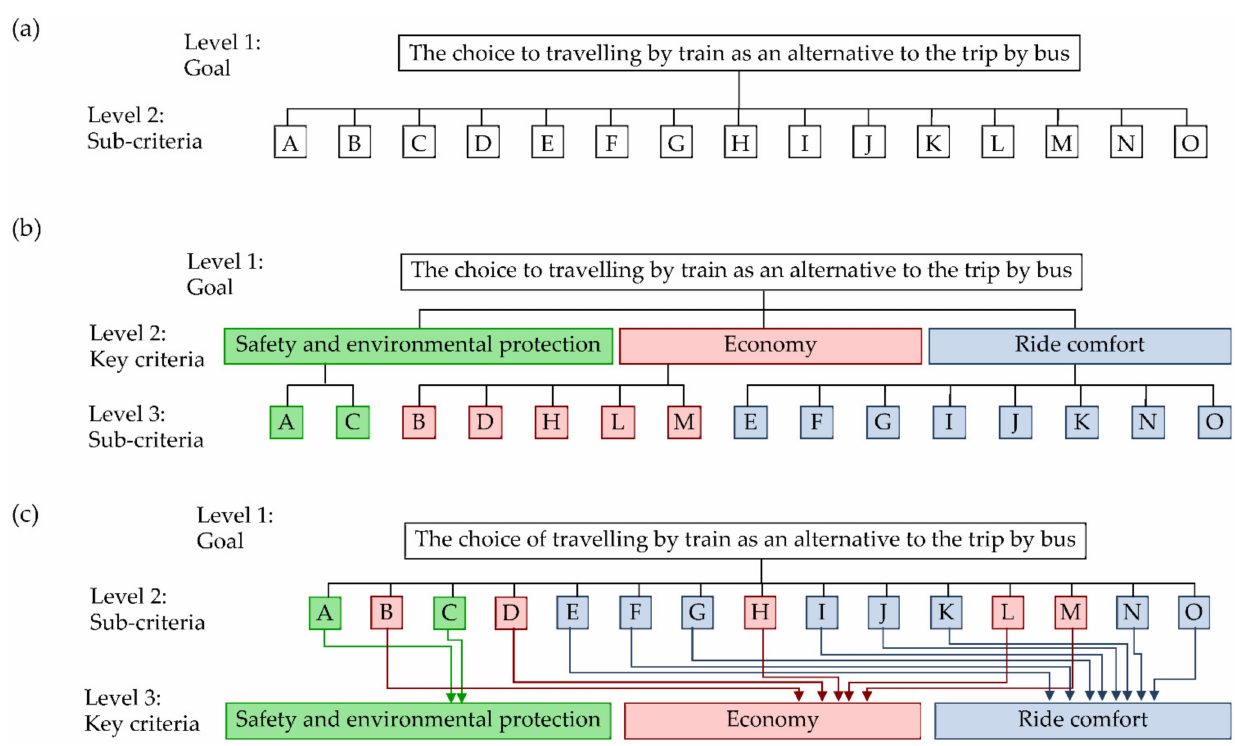
Figure 2. Calculating the weights of criteria determining the choice of passengers to travel by train as an alternative mode of transport to travel by bus using: ( a )—non-hierarchical model; ( b )—a classical (direct) hierarchy model; ( c )—an inverse hierarchy